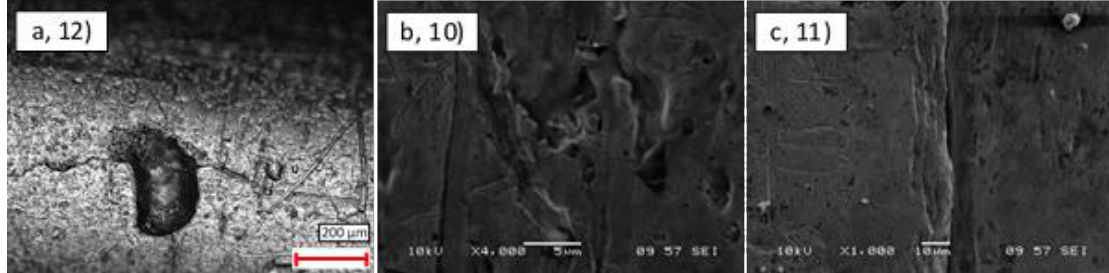
Figure 11. External surface damage on the three leak pipes: ( a ) unknown leak rate (12); ( b ) 3 × 10 −7 leak rate (10); ( c ) 7 × 10 −4 leak rate (11).